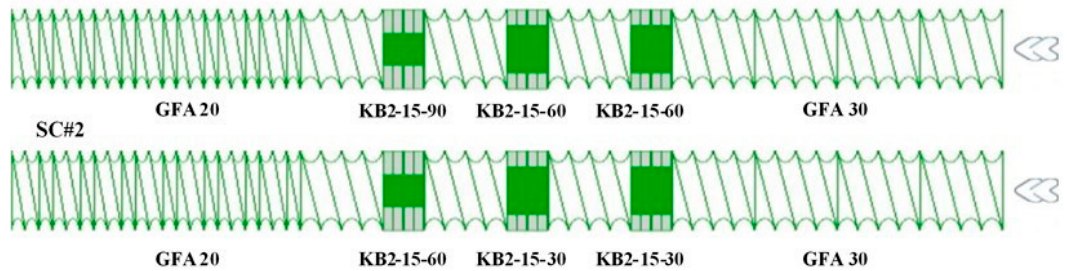
Figure 1. Screw configurations used for twin-screw melt granulation. GFA 30 (conveying) and GFA 20 (conveying) represent conveying screw elements with pitch 30 and 20 mm, respectively. KB2-15-30, KB2-15-60 and KB2-15-90 represent blocks of kneading elements with screw elements rotating at an offset angle of 30, 60 and 90°, respectively. Screw configuration#1 (SC#1) with kneading elements rotating at 60 and 90° provided higher shear to the material than screw configuration#2 with kneading elements rotating at 30 and 60°. When extruding blends of metformin HCl and HPC GXF with screw configuration SC#1, a higher extruder torque was observed, ranging from 8–12%. Higher extrusion tem- peratures of 160 and 140 °C showed a higher operating torque than the lower tempera- tures 120 and 100 °C. In the case of HPMC HME 4M, a torque of 4–6% was only observed when extruding at 160 °C with screw configuration SC#1. Extrusion at 100, 120 and 140 °C showed minimum extruder torque ( ≤ 3%) during the process. When the screw configura- tion was changed to a lower shear screw configuration SC#2, the torque remained around 8–12% in the case of HPC GXF, whereas melt granulation with HPMC HME 4M showed a minimum extruder torque at all temperatures. Extruder torque is an indication of the force the motor exerts to move the screws to push the material forward. A higher extruder torque in melt granulation sometimes indicates a better agglomeration or compaction of material into dense granules. 3.2. Granule Properties In twin-screw melt granulation, process conditions, as well as the melt viscosity of the binder, can impact the granule properties. Using screw configuration SC#1 for the ex- trusion of HPC GXF, granule shape and appearance were affected when the processing temperature was varied from 100 to 160 °C, as shown in Figure 2a. At a lower processing temperature of 100 °C, the granules were hard agglomerates (centimeter), but smaller in size. As the temperature was increased from 100 to 120 °C, the granule morphology changed to more ribbon-like granules. At higher temperatures of 140 and 160 °C, the gran- ules produced were more consistently continuous and ribbon-shaped. The granule mor- phology indicated that, at higher temperatures, HPC had a lower melt viscosity and in- creased binding capacity to bind and agglomerate metformin HCl to produce ribbon- shaped granules. It was apparent that these granules or extrudates were to be milled to produce smaller particles that could provide an acceptable flow for tableting. When the screw configuration was changed to a low shear SC#1, no significant change in granule morphology was observed. Ribbon-like extrudates were obtained at high temperatures of 140 and 160 °C and hard agglomerates were obtained at 100 and 120 °C. In the case of HPMC HME 4M, when the processing temperature was varied from 100°C to 160 °C, HPMC HME 4M granule quality showed a significant variability, as shown in Figure 2b. For HPMC HME 4M, granules were only obtained at 160 °C. At lower temperatures, the polymer did not fully melt, yielding a fine powder and granules of an irregular nature. Nonetheless, it was anticipated that granules obtained with HPMC HME 4M may still provide adequate tablet strength. When the screw configuration was changed to a lower shear, SC#2, fine particles were obtained at all temperatures. There